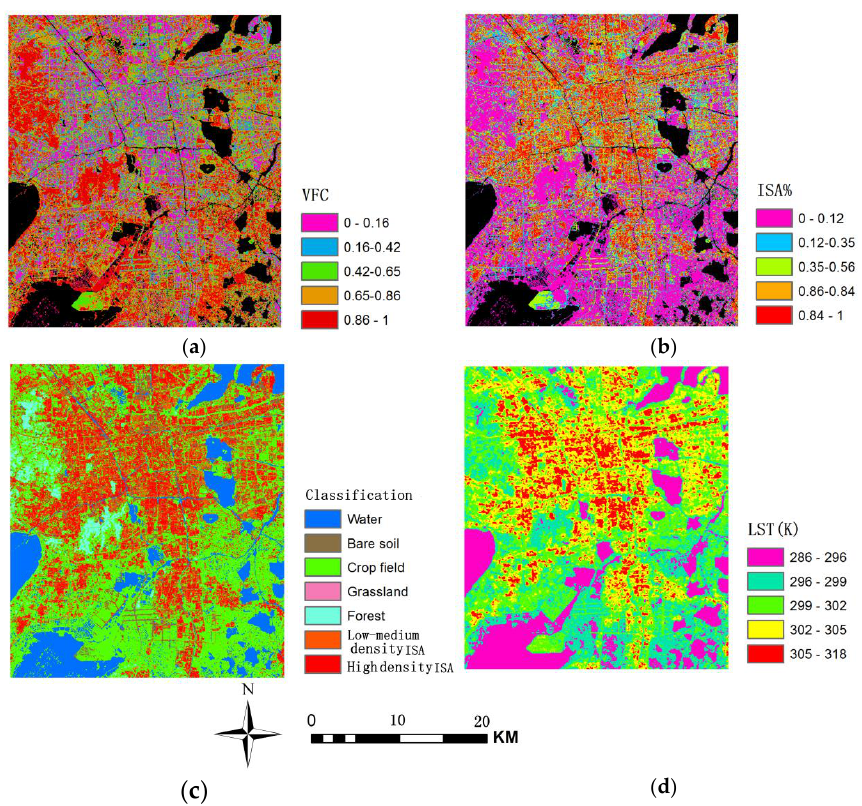
Figure 4. Maps of land coverage, LCTs classification and LCT at 1040 LT, derived from 30-m LANDSAT-5 TM acquired on 24, May 2010. ( a ) Vegetation fraction coverage; ( b ) impervious surface coverage; ( c ) LCT classification; ( d ) land surface